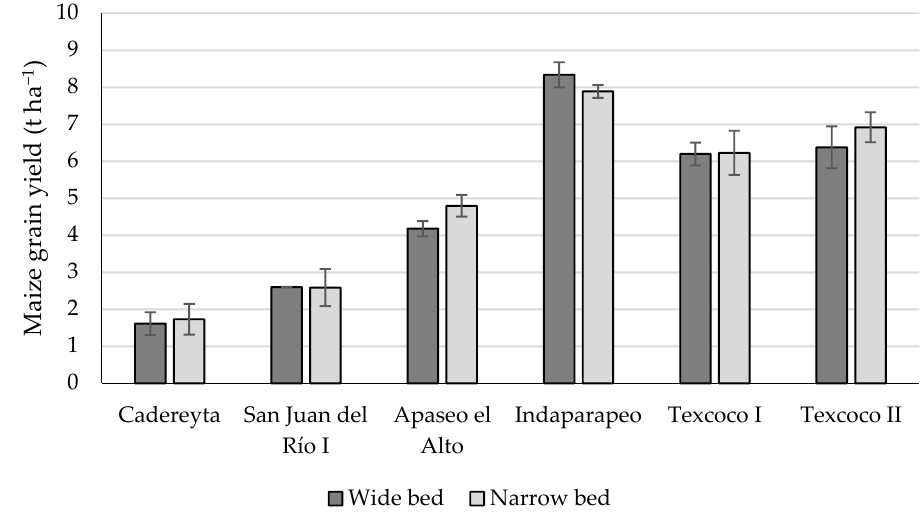
Figure 4. Maize yield with planting in wide, narrow beds at six sites in central Mexico. Average yield during the duration of the study; the error bars represent the standard deviation of the mean. Apaseo el Alto, in Guanajuato, has the soil with the highest clay content of the studied sites and a low average precipitation of 550 mm. In almost all cycles, the highest yield